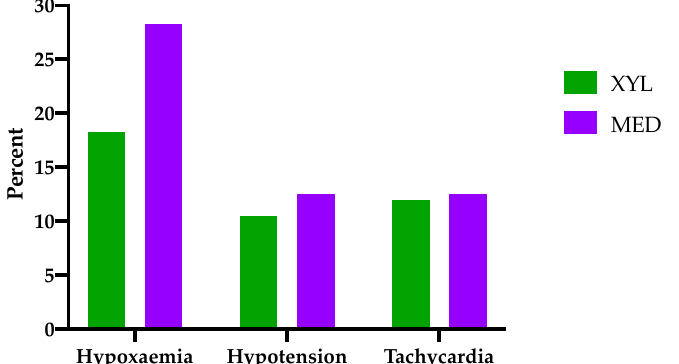
Figure 1. Comparison of the occurrence of intraoperative hypoxaemia, hypotension, and tachycardia between horses treated with either isoflurane–xylazine balanced anaesthesia (XYL, n = 191) or isoflurane–medetomidine balanced anaesthesia (MED, n = 279).